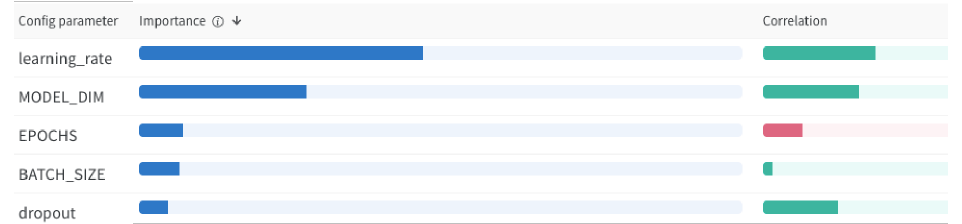
Figure 4. Hyperparameter relevance. Green indicates a positive correlation and red a negative